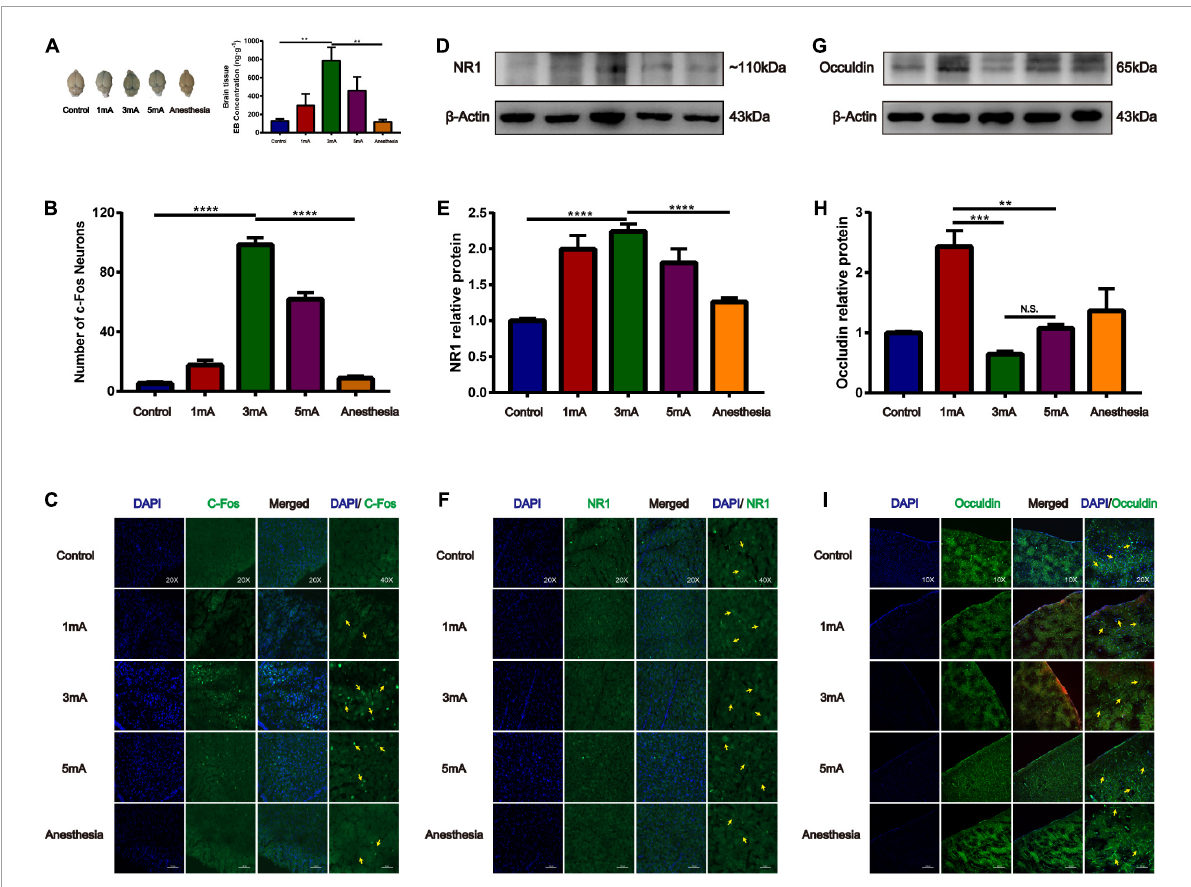
FIGURE5 Different intensities of EA of trigeminal nerve on promoting BBB opening and its effect on tight junction protein occludin. (A) Shows the degree of brain EB penetration after different intensities of EA of trigeminal nerve under naked eye observation. EB concentration in the cerebral cortex; ** P < 0.01, EA 3 mA group vs. control group and anesthesia (based on EA 3 mA) group; n = 6/group. (B) Number of c-Fos Neurons in the frontal cerebral cortex, four slices from each individual rat used for average; **** P < 0.0001, EA 3 mA group vs. control group and anesthesia group; n = 4/group. (C) Different intensities of EA of the trigeminal nerve, EA 3 mA group shows the most significant c-Fos fluorescence expression (yellow arrows). (D,E) Compared to the control group, NR1 protein expression was increased in all the EA groups, but the increase was most significant in the EA 3 mA group, and NR1 protein expression was decreased after anesthesia, *** P < 0.001, EA 3 mA group vs. control group and anesthesia group, n = 6/group. (F) Cerebral cortex NR1 fluorescence expression. The 3 mA group had the most pronounced expression. (G,H) The EA 3 mA group occludin protein expression was significantly decreased and no significant change was observed after anesthesia. But the EA 1 mA group had significantly increased expression, *** P < 0.001, 1 mA group vs. 3 mA group, ** P < 0.01, 1 mA group vs. 5 mA group, P > 0.05, 3 mA group vs. 5 mA group, n = 6/group. (I) The EA 3 mA group occludin protein fluorescence expression was complete, with continuity after anesthesia (yellow